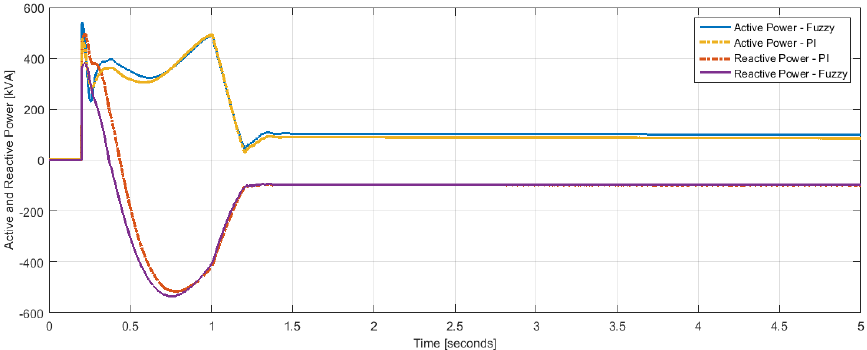
Figure 12. Active and reactive power in case of V2G [kVA].